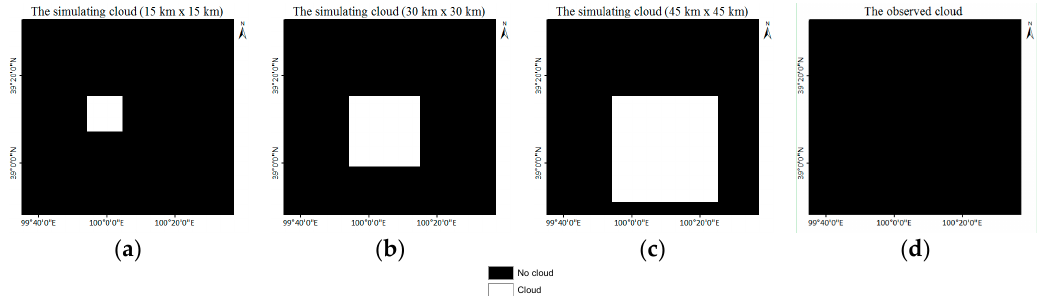
Figure 6. The simulated cloud areas: ( a ) 15 km × 15 km; ( b ) 30 km × 30 km; and ( c ) 45 km × 45 km; and ( d ) the observed cloud product from MODIS.